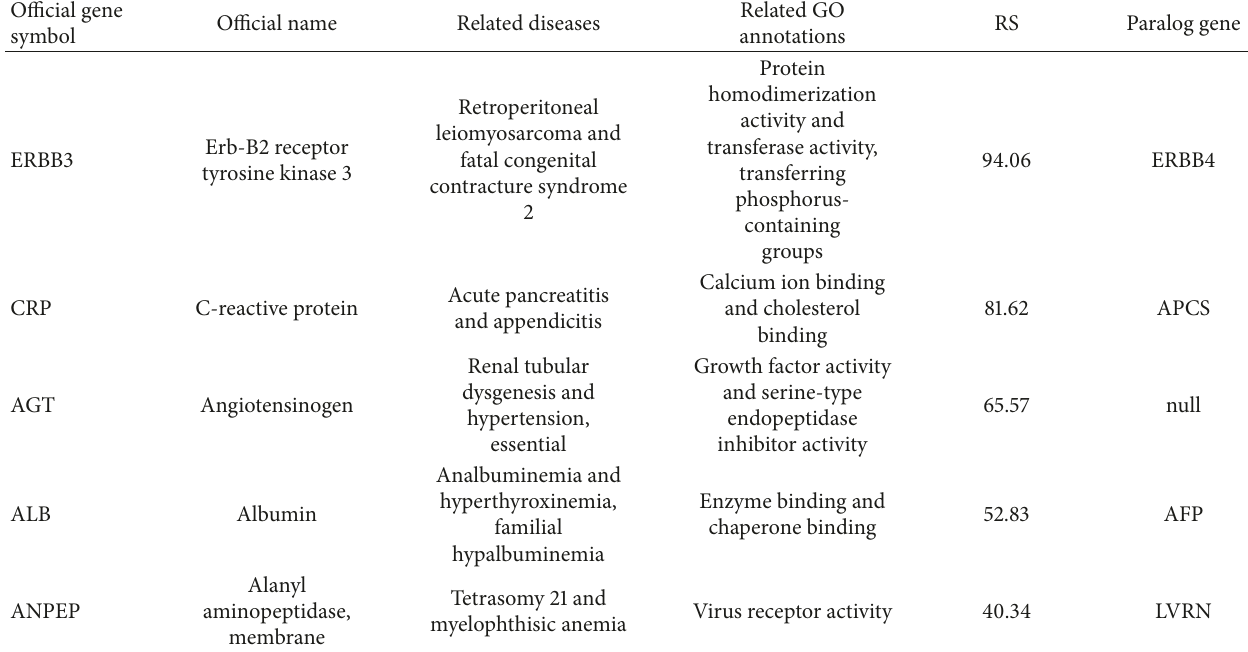
Table 10: Unique co-differentially expressed genes by HDNMF (INTA 2).